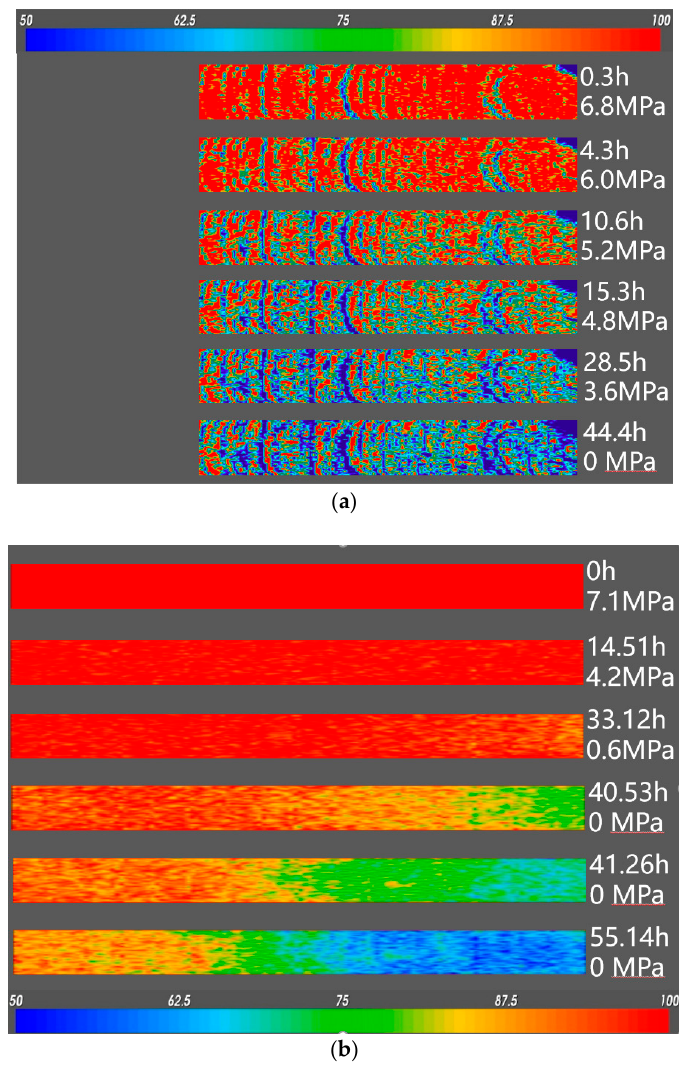
Figure 4. Oil saturation CT reconstruction images for Experiments 1 and 2. ( a ) Step-down Experiment 1; ( b ) Linear Experiment 2.